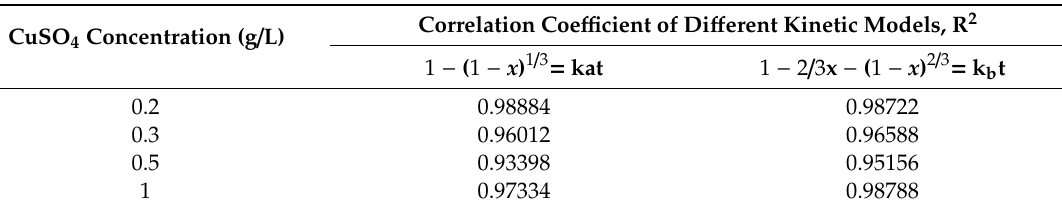
Figure 10. Arsenic removal kinetic at different CuSO 4 concentrations.